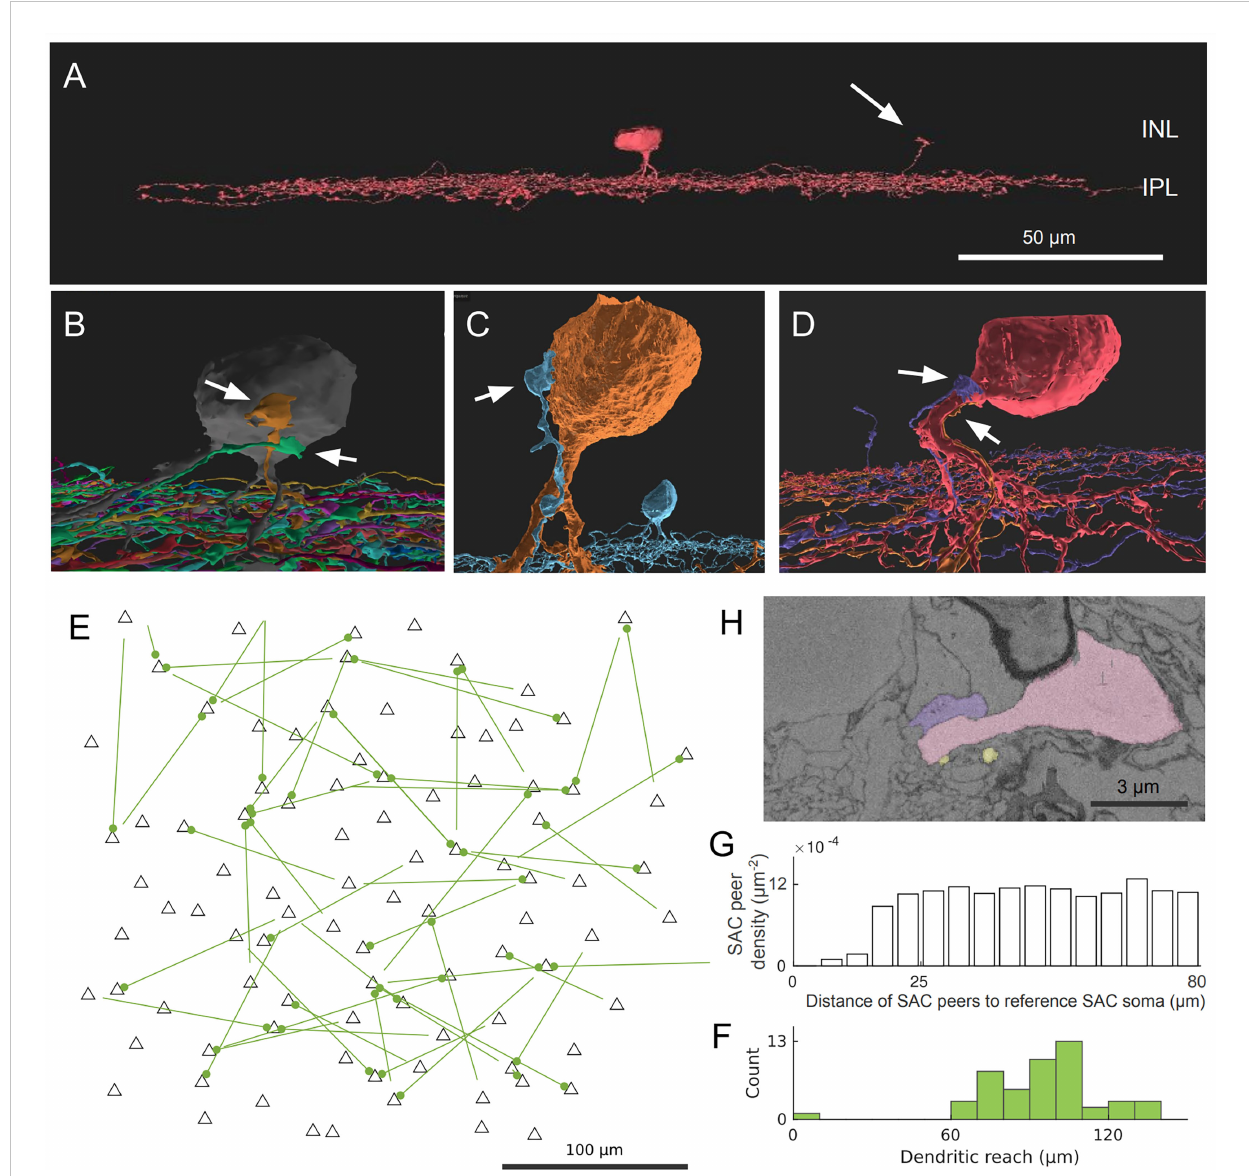
FIGURE 1 Off SAC contact pattern. (A) Tangential view of a 3D-reconstructed Off SAC. An ascending dendrite (arrow) veers off from the dendritic strati fi cation and into the inner nuclear layer (INL). (B – D) In each of these 3D perspective views, attached to the soma or basal dendrite of an Off SAC, we see ascending dendrites (arrows) from other Off SACs like in (A) , usually climbing along the perisomatic dendrite. (E) Spatial distribution of the somatic origin and attachment points of these ascending dendrites in the retinal patch ( fl at-mount view). Each line represents the dendritic branch starting from the originating cell ’ s soma (the bare end of the line) and grasping onto the targeted cell ’ s perisomatic membrane (the bulged end of the line as a dot); black triangles are soma locations of all reconstructed Off SACs with soma inside the retinal patch. (F) Histogram showing the distribution of these ascending dendrites ’ dendritic reach, de fi ned as the planar distance from the ascending dendrite ’ s originating soma to the soma where it terminates. Minimum, quartiles, and maximum: 9, 81, 97, 104, and 137 m m. (G) The density recovery pro fi le, for all Off SAC somas, regardless of whether any ascending dendrite contact or not, is de fi ned as the average density of somas at given distances from any given soma (20). (H) A mini region of the plasma-membrane-stained retina sample, shown as a sectional electron micrograph near the locations pointed to in (D) , overlaid with the respective reconstructed cells ’ colors matching panel (D) . Scale bars: 50 m m (A) ; 100 m m (E) ; 3 m m (H)